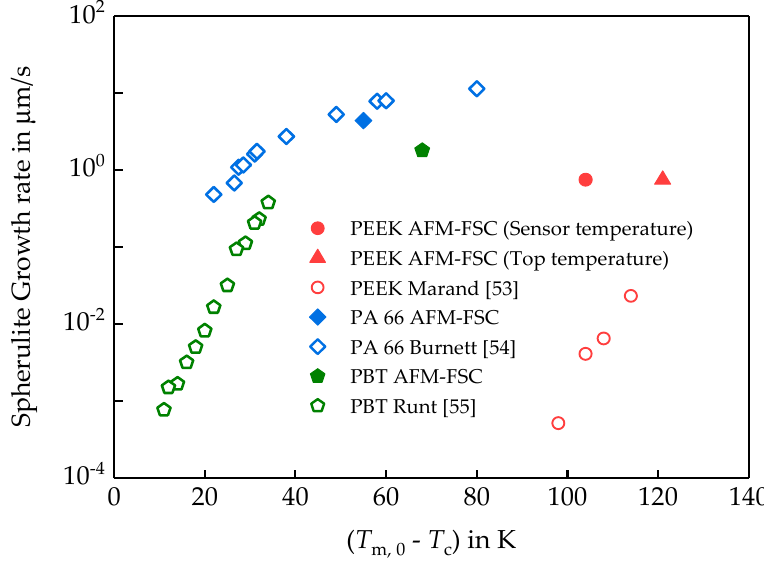
Figure 11. Spherulite growth rates of different polymers measured by AFM-FSC and polarized light (POM) as a function of undercooling below T 0 m . The corresponding AFM images are shown in Supplementary Materials A3. The equilibrium melting temperatures were taken from Table 1. Growth rates from POM were taken from the literature: PEEK [58], PA 66 [62], and PBT [63]. Throughout, filled symbols represent data obtained by AFM-FSC, while open symbols were taken from the literature, gained by POM.